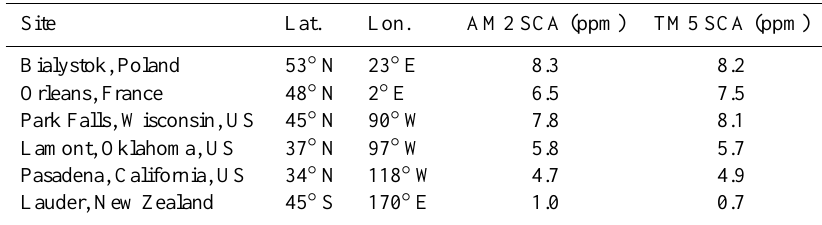
Table 1. TCCON sites sampled in AM2. Site locations are listed, as well as the seasonal cycle amplitude (SCA) from AM2 and TM5 when CarbonTracker year 2008 fluxes underlie the two models. Site Lat. Lon. AM2 SCA (ppm)